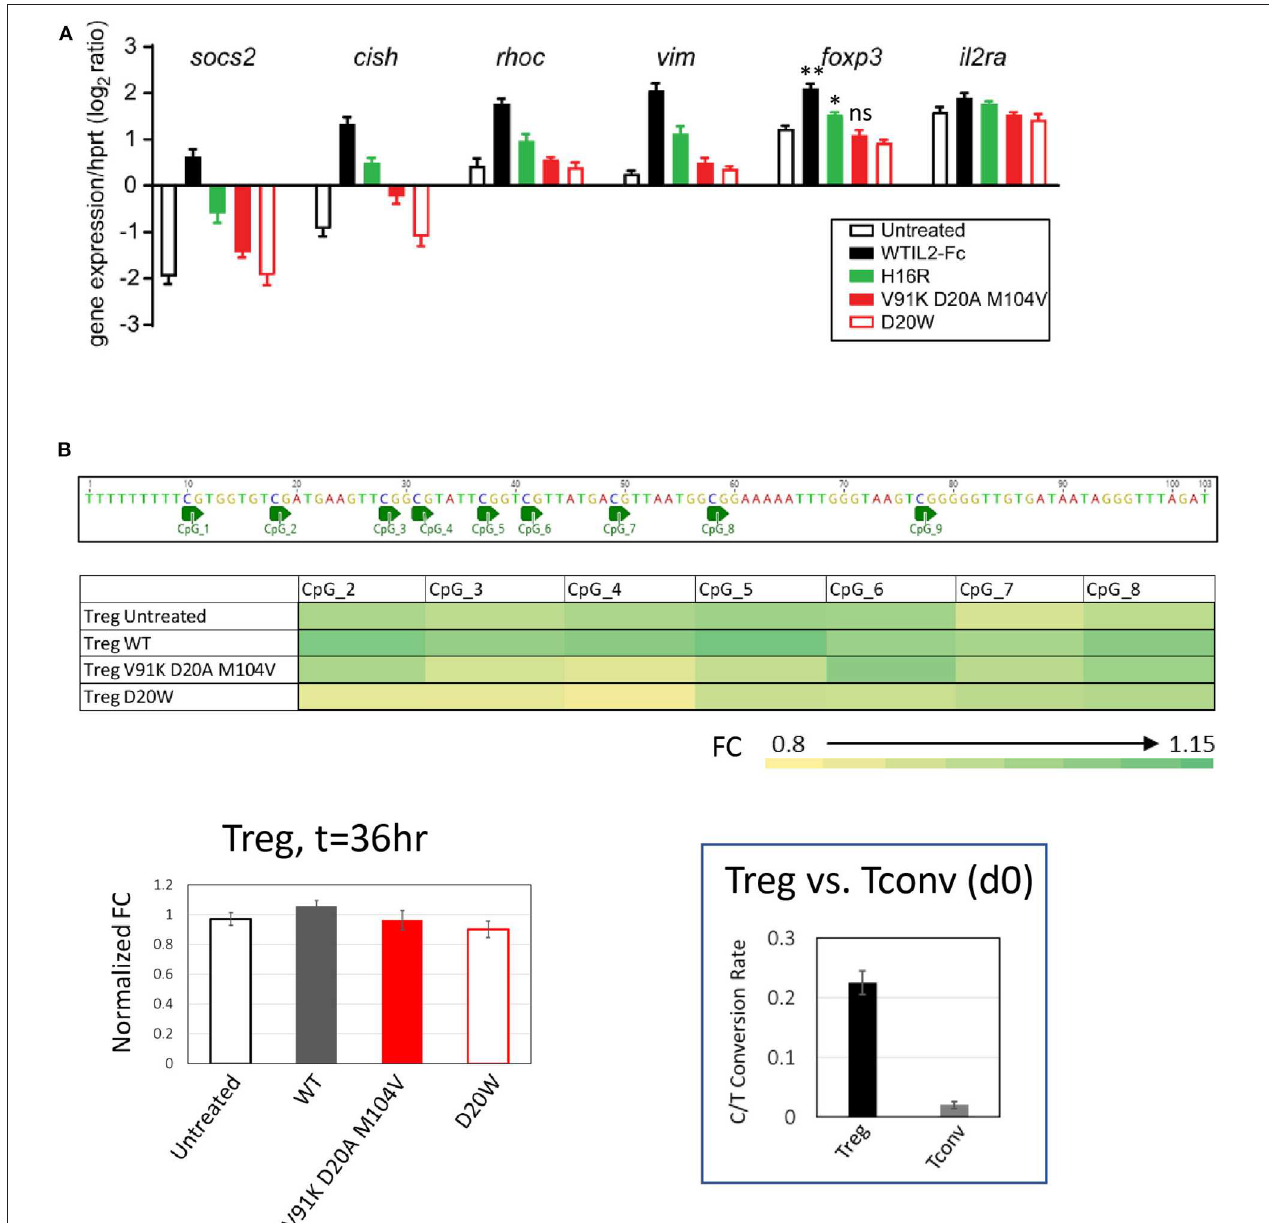
FIGURE 5 | Treg-associated gene response is quantitatively sensitive to attenuated IL-2 mutein activity. (A) Transcript levels of socs2 , cish , rhoc , vim , foxp3 , and il2ra were quantified by Taqman assay in purified human Treg cells stimulated with various IL-2 muteins for 36h. The results represent the mean ± SD of relative expression values (log2 ratio) for the indicated genes normalized to hypoxanthine-guanine phosphoribosyl transferase ( hprt ) in two independent donors with three replicates each. For foxp3 , paired t -test was performed for each treatment group against the untreated sample and two-tailed p -values are indicated. ** p = 0.0076; * p = 0.0165. (B) Methylation status of foxp3 CNS2 region in human Treg cells cultured in IL-2 muteins. Methylation status was quantified as C-to-T conversion rate after bisulfite treatment. The fold change (FC) values were calculated based on the C-to-T conversion rates at individual CpG sites and normalized to Day 0 sample. The average FC values from three donors are plotted into heatmap. The average FC values calculated from the combined CpG sites were plotted as bar graph to show IL-2 mutein dependent effects. The BS4 amplicon sequence and CpG positions were illustrated above the heatmap. Shown in the inset is the representation of the overall C-to-T conversion rates for purified Treg and Tcon cells on day